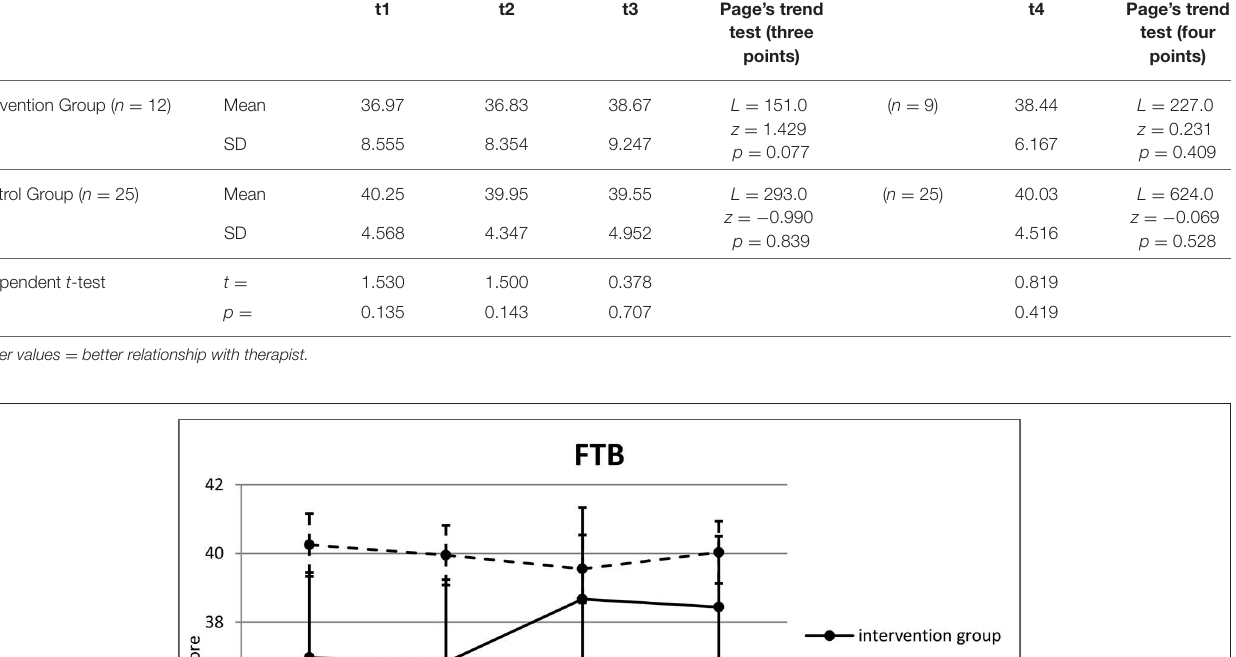
TABLE 4 | Questions about the Therapeutic Relationship. FTB Page’s trend